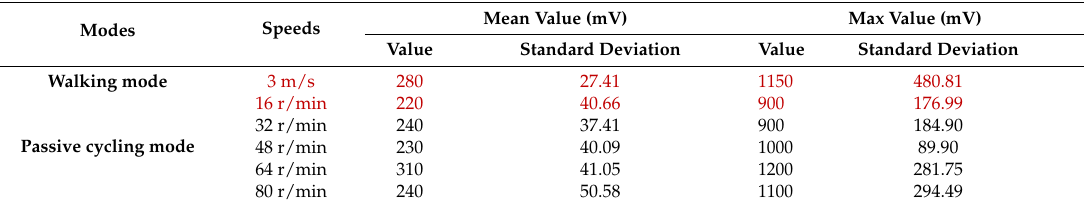
Table 2. Recorded EMG signals at 9 s for different motion modes and